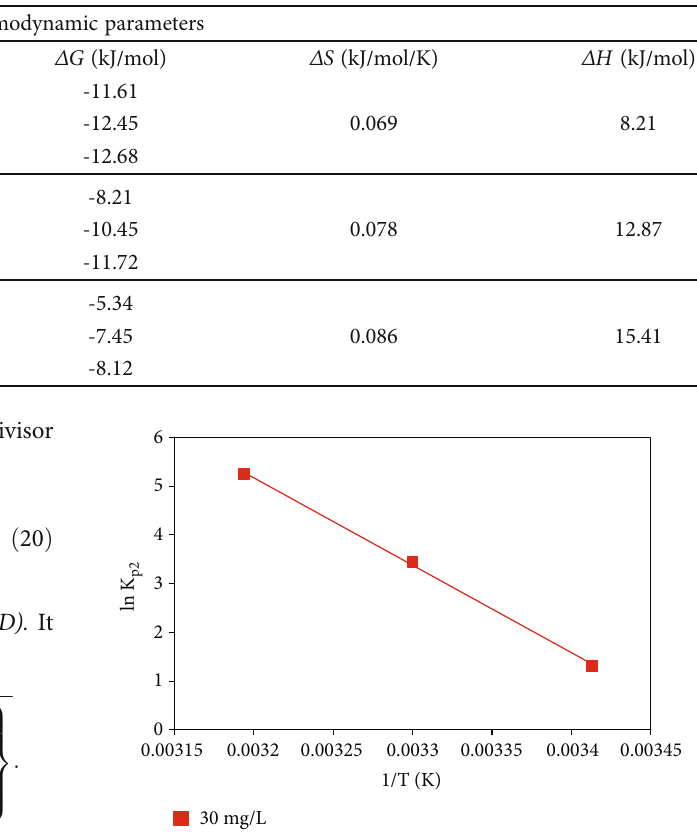
Figure 19: Plot between ln K g/L , and time = 120 min